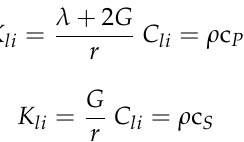
Figure 14. Lanzhou motion in the vertical direction after inversion.